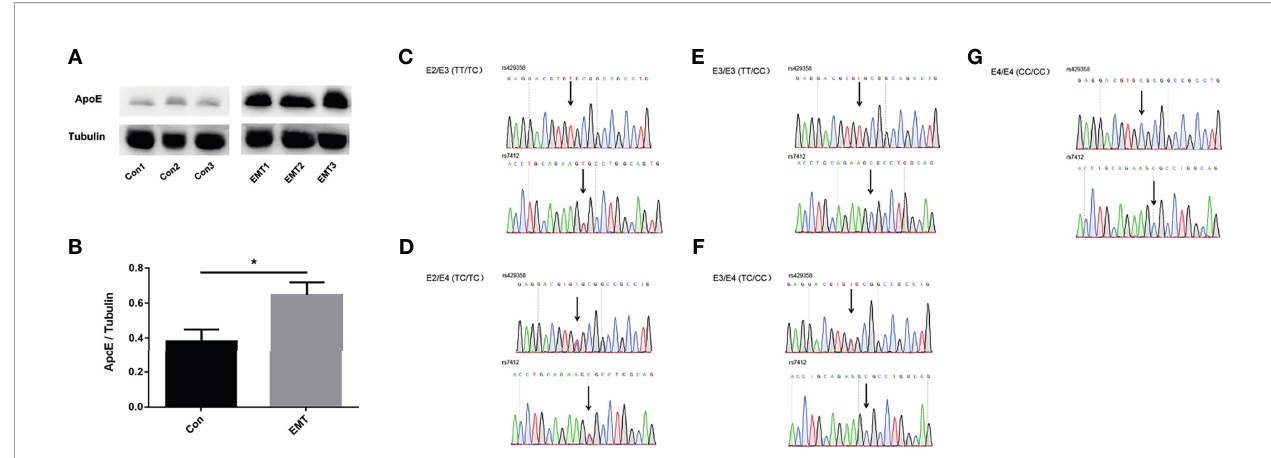
FIGURE 1 | ApoE levels in the follicular fl uid (FF) of the control group and patients with EMT. (A, B) Representative Western blotting results showing ApoE expression in the FF of the control subjects and the patients with EMT. Tubulin was used as an internal control. The data are expressed as the means ± SEMs; * p < 0.05. (C – G) Representative Sanger sequencing for E2/E3,E2/E4,E3/E3, E3/E4,E4/E4 genotype; The arrows indicate the positionof the single nucleotide polymorphism.